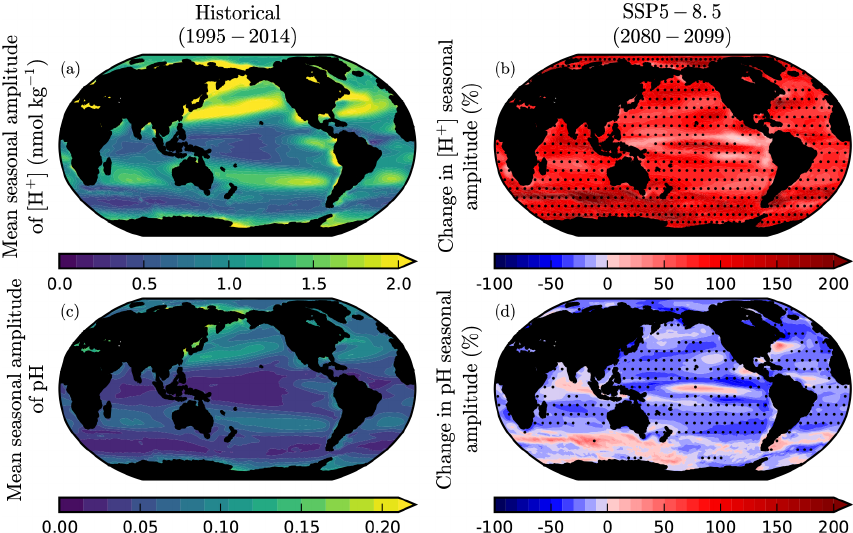
Figure 10. Change in the seasonal amplitude of surface ocean [H + ] and pH. The CMIP6 historical climatologies and SSP5-8.5 anomalies in peak-to-peak seasonal amplitude of surface ocean (a, b) [H + ] and (c, d) pH. Anomalies are calculated from the mean seasonal amplitude in 2080–2099 relative to that in 1995–2014. Stippling designates robustness, as defined by at least 80% model sign